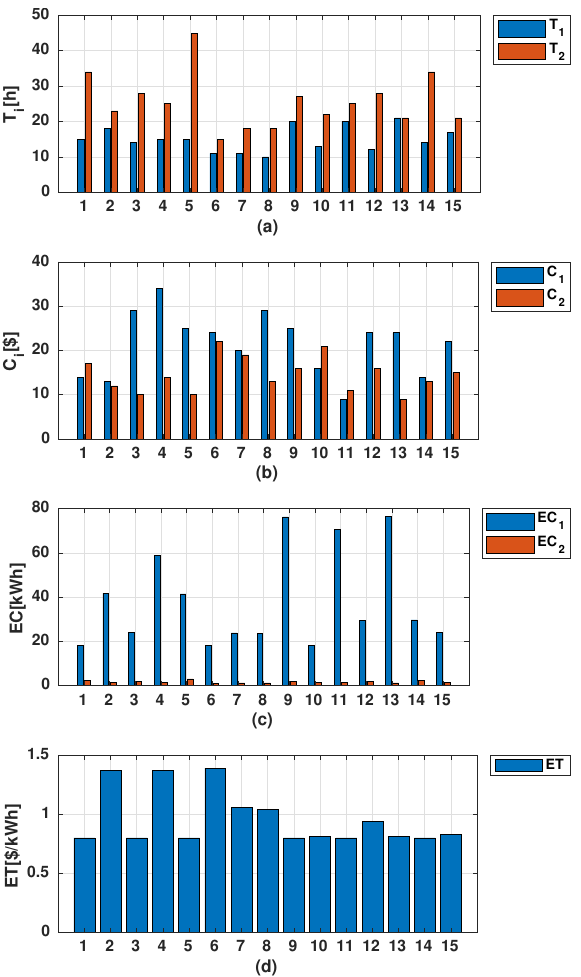
Figure 10. Test 4—processing times ( a ), costs ( b ), energy consumption ( c ) and energy cost ( d ) varia- tions. In sub-figure ( a – c ), blue bar and red bar refer to the standard ( i = 1) and fermentation-based ( i = 2) extraction process, respectively. The x-label refers to the number of performed